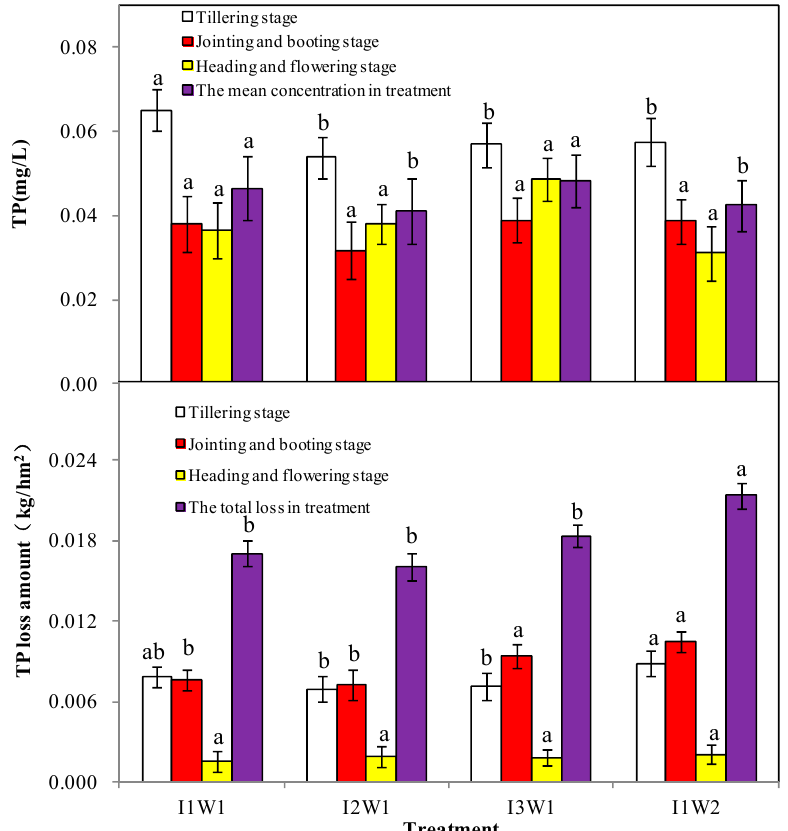
Figure 5. TP losses for ground water discharge in di ff erent irrigation treatments. TP means total phosphorus. I1W1 represents shallow–frequent irrigation with aquaculture wastewater; I2W1 represents shallow–wet irrigation with aquaculture wastewater; I3W1 represents flooding irrigation with aquaculture wastewater; I1W2 represents shallow–frequent irrigation with fresh water. Data are mean ± SD ( n = 4). The di ff erent letters on the tops of columns indicate significant di ff erences between treatments at 5% according to Duncan’s multiple range test.